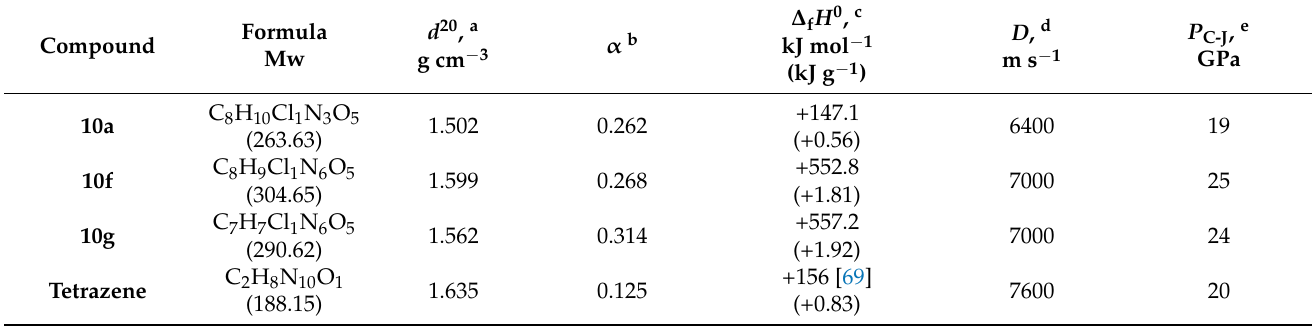
Table 4. Explosive performance for compounds of this study in comparison with